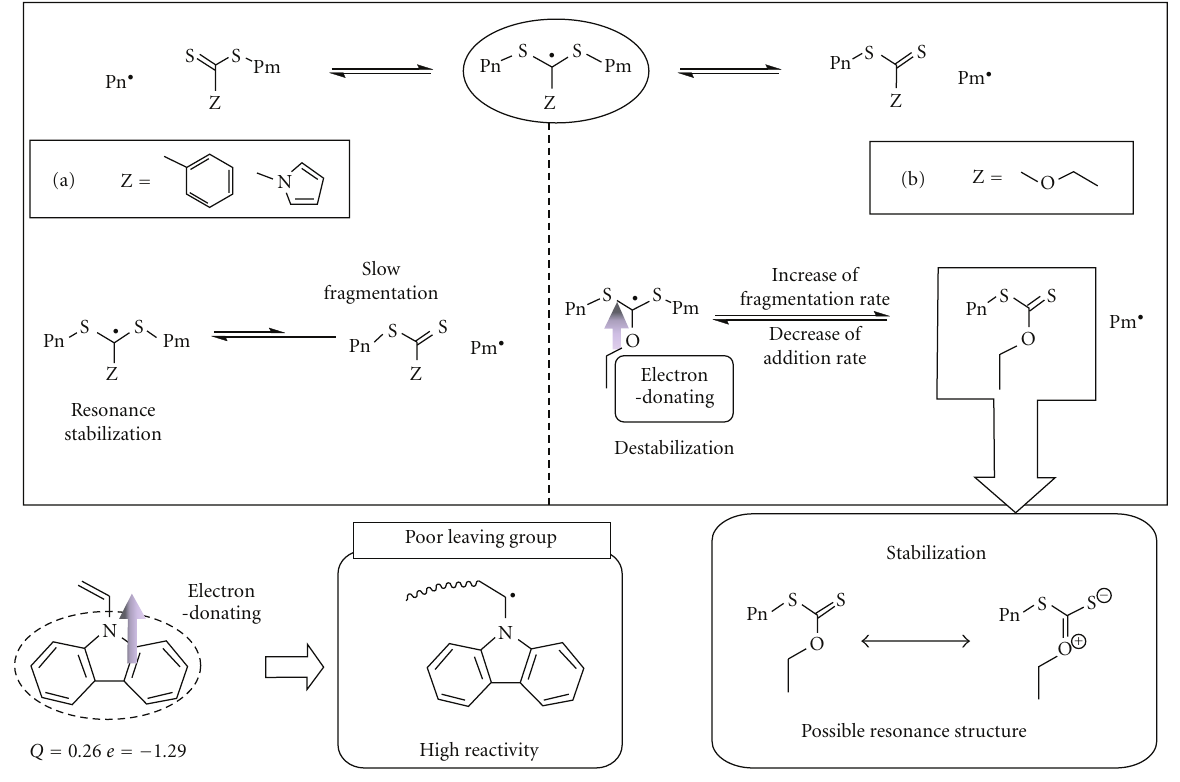
Scheme 2: Proposed mechanism of xanthate-mediated controlled radical polymerization of